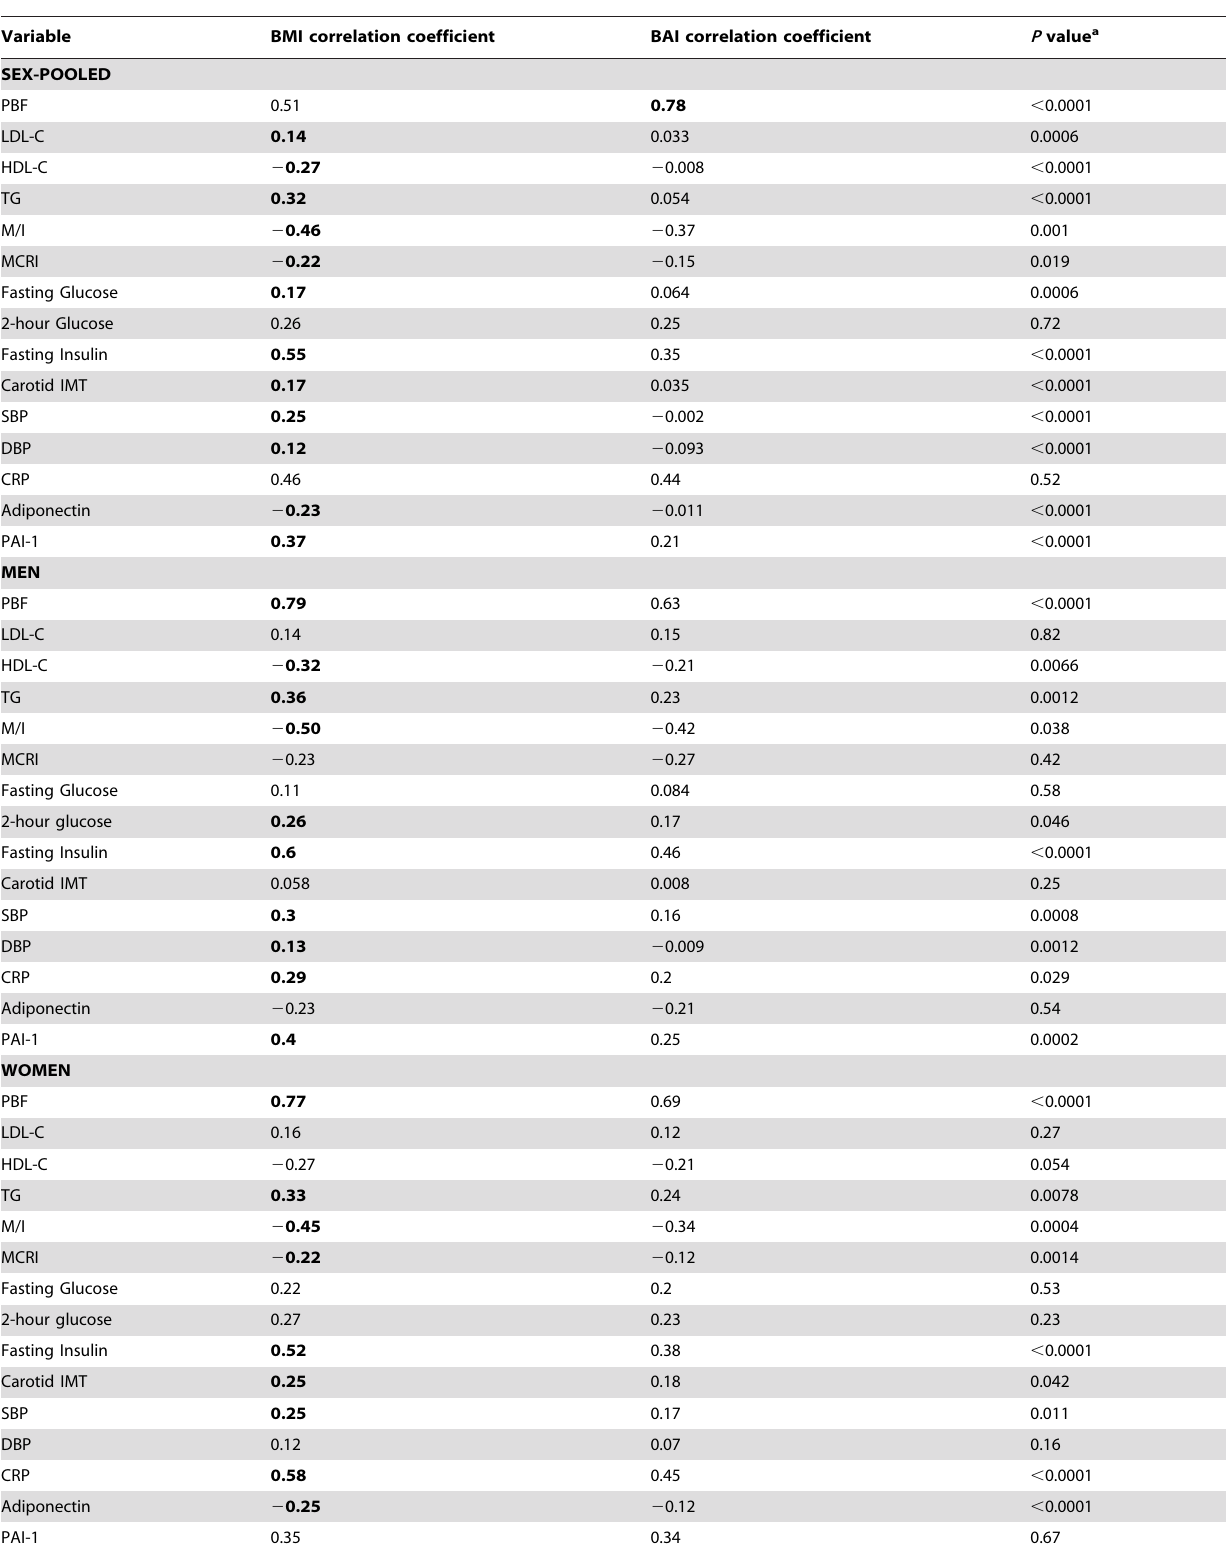
Table 3. Comparison of correlation coefficients between cardiometabolic risk factors and BMI versus